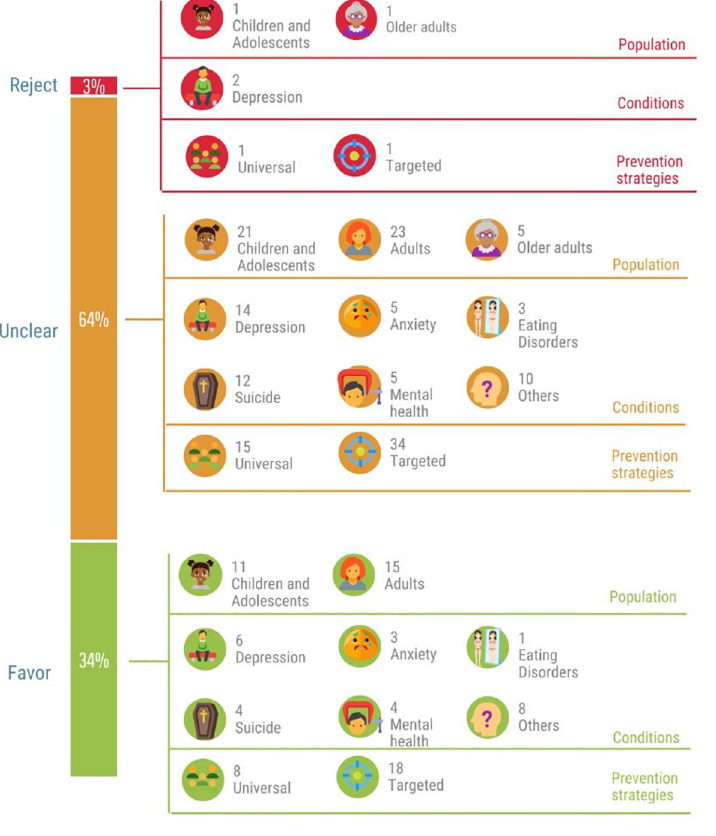
Fig 2. Cost-effectiveness results and implications for